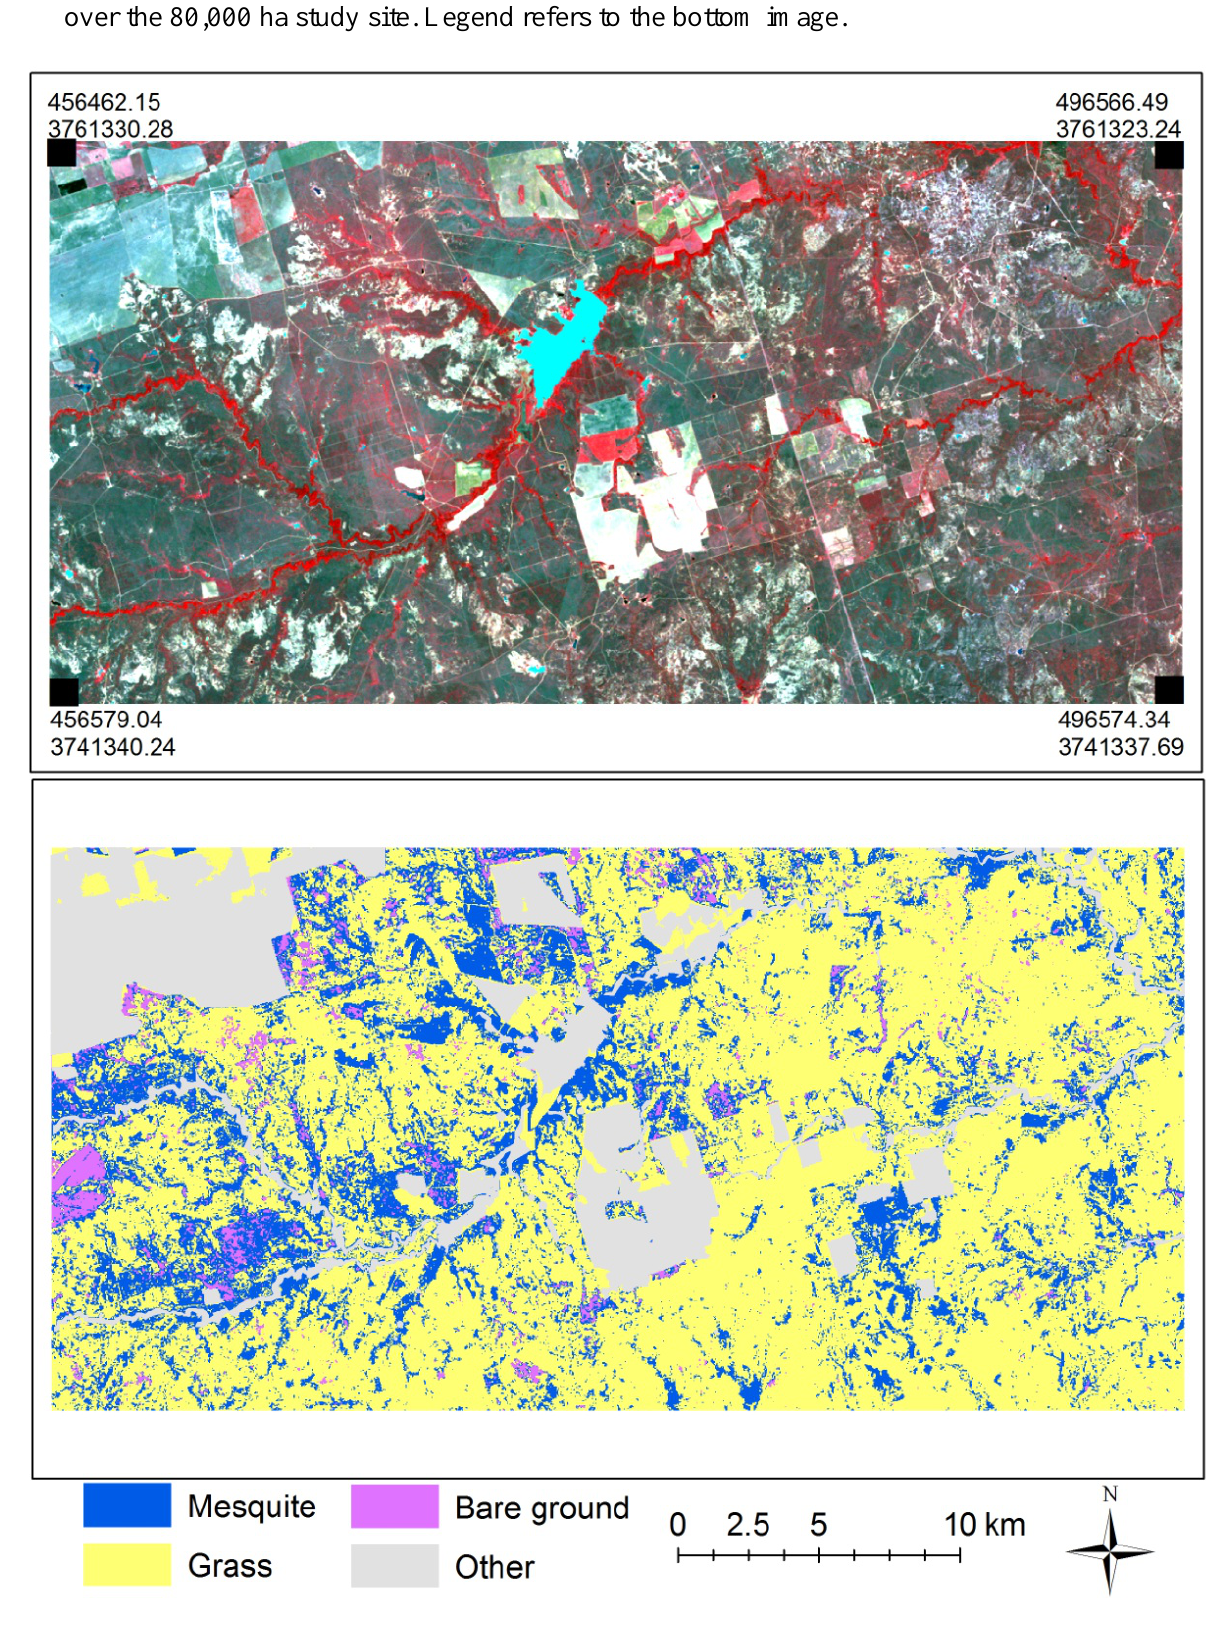
Figure 3. Color infrared Landsat 5 TM imagery with 30-m spatial resolution ( top ) and classified imagery for mesquite, grass, bare ground, and other land cover types ( bottom ) over the 80,000 ha study site. Legend refers to the bottom